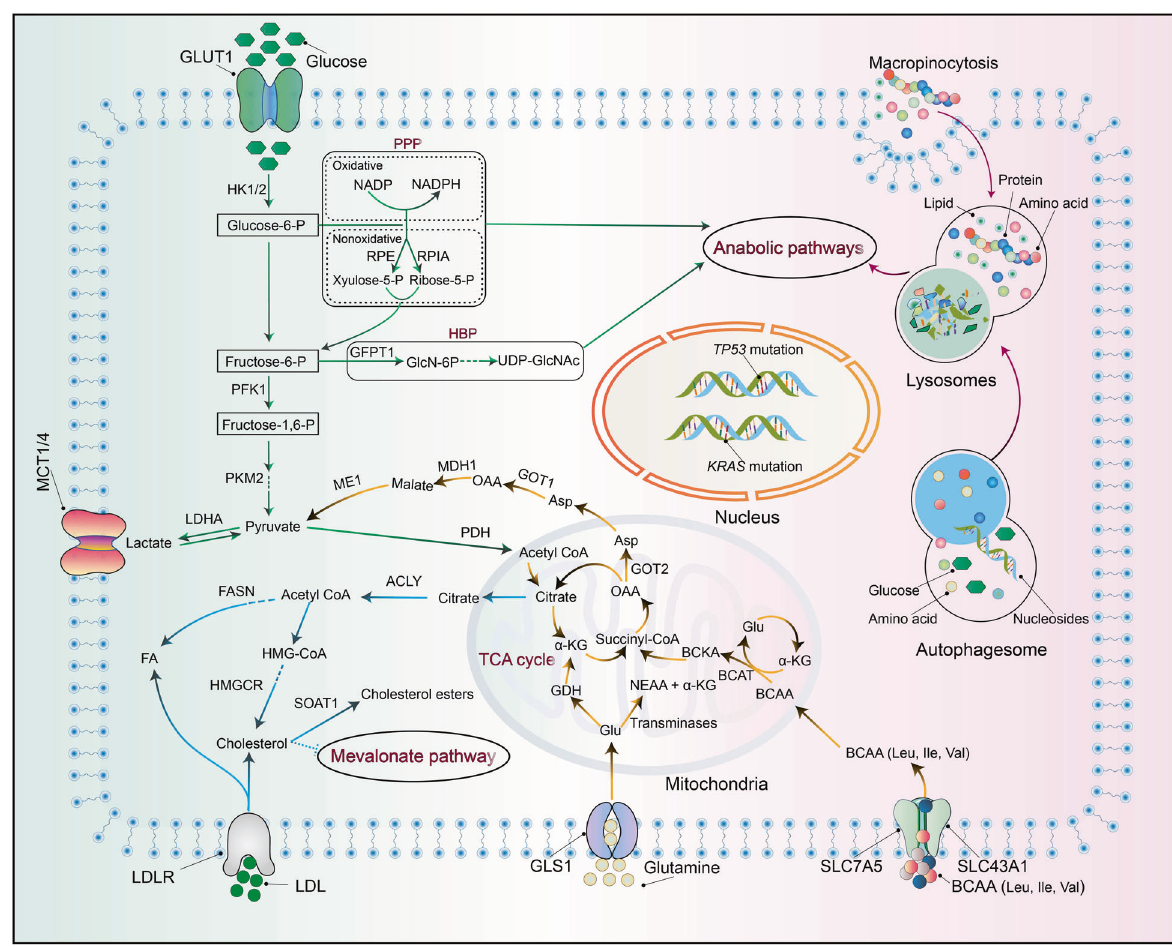
Fig. 2 Metabolic reprogramming in pancreatic cancer cells. KRAS activation and mutant TP53 enhance glucose metabolism to provide biosynthetic precursors for anabolic pathways, including the non-oxidative arm of the pentose phosphate pathway (PPP) and the hexosamine biosynthesis pathway (HBP). KRAS activation reprograms glutamine metabolism to sustain cellular redox homeostasis by increasing the NADPH/NADP + ratio and recycling glutathione (GSH) via reduction of oxidized GSH. The BCAT2-mediated BCAA catabolism driven by KRAS plays a critical role during pancreatic cancer development. Enhanced nutrient salvaging, via the induction of macropinocytosis and autophagy, provides energy and regenerative nutrients, including glucose, amino acids, lipids, and